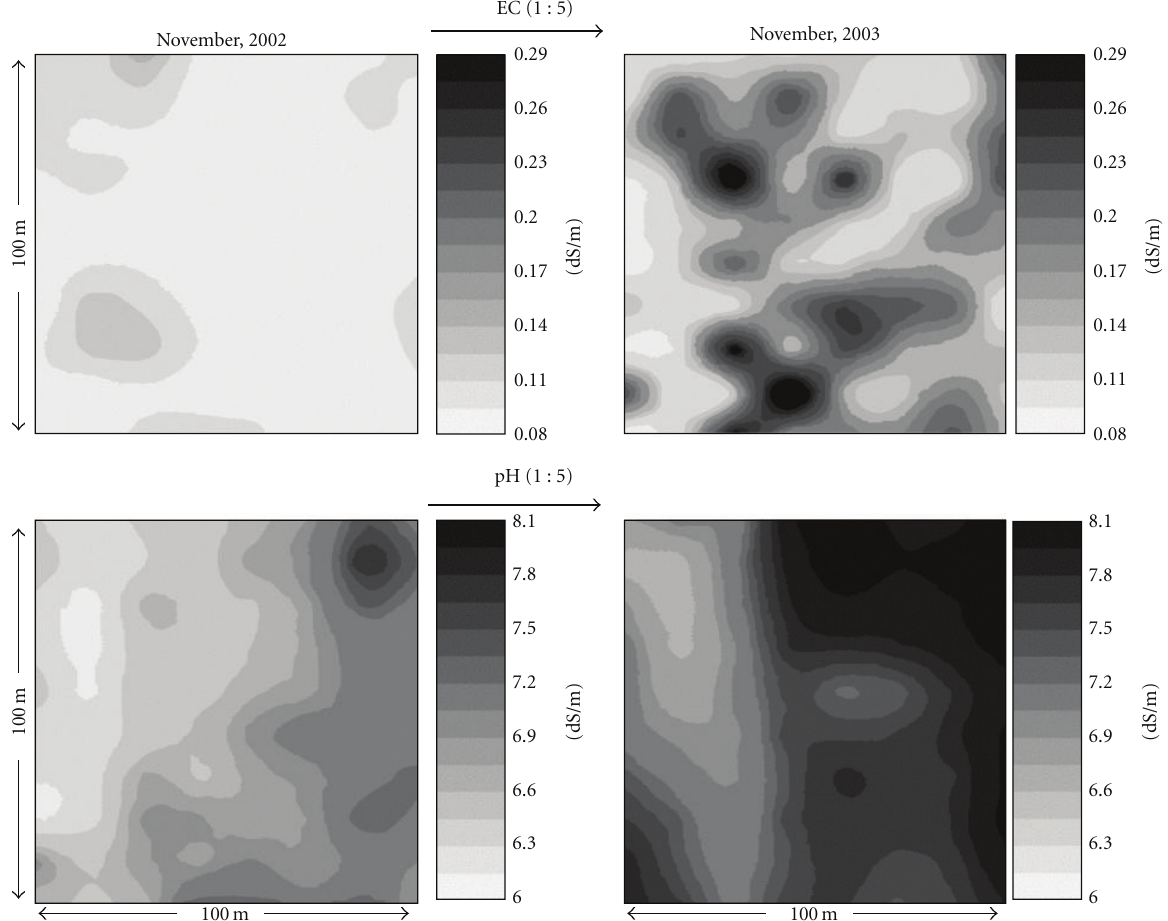
Figure 2: Change in spatial variations of the salt accumulation status (EC 1:5 and pH 1:5 ) in surface soil at Site 1 from 2002 to 2003.